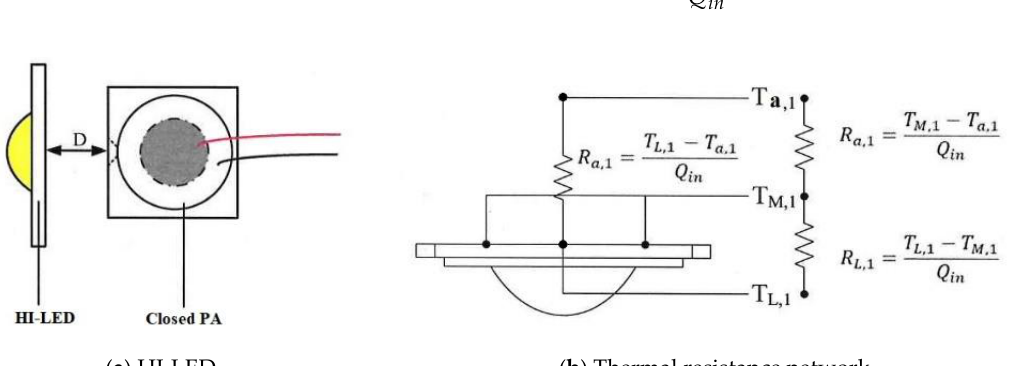
Figure 8. LED Module